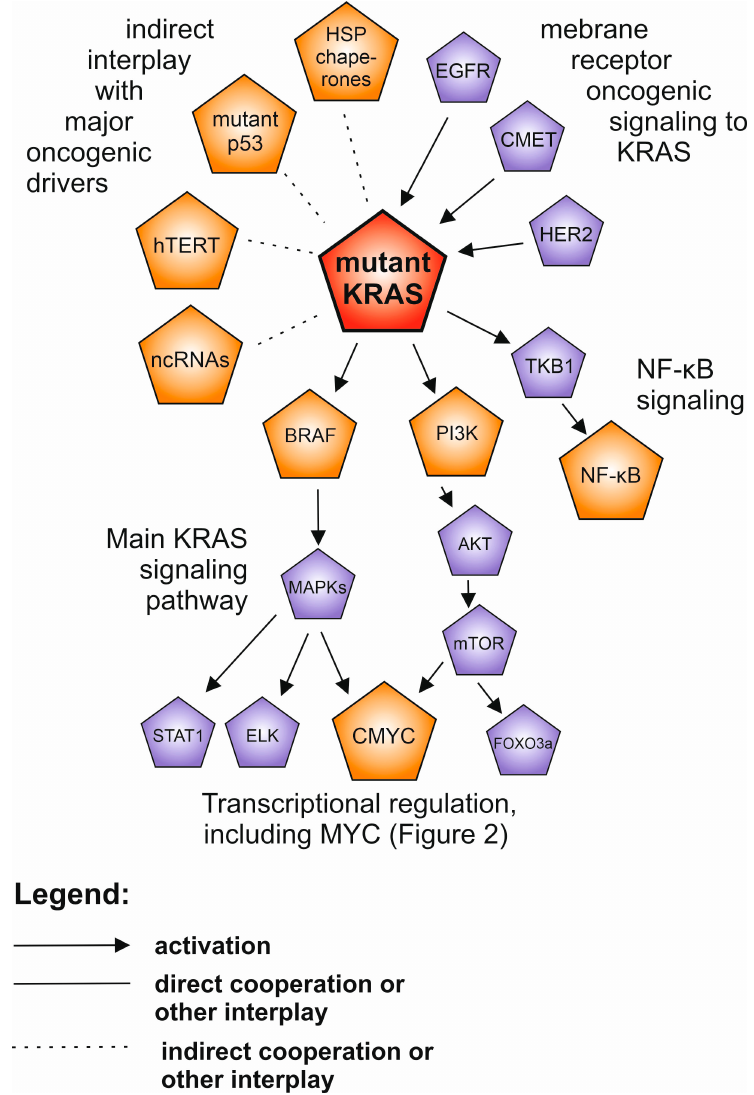
Figure 3. The network of the interplay between mutant KRAS (highlighted in red) and other oncogenic drivers in human neoplasia. The drivers described in separate paragraphs are shown in orange, while additional oncoproteins are shown in purple. Only the selected and well supported connections are shown, described in the text.